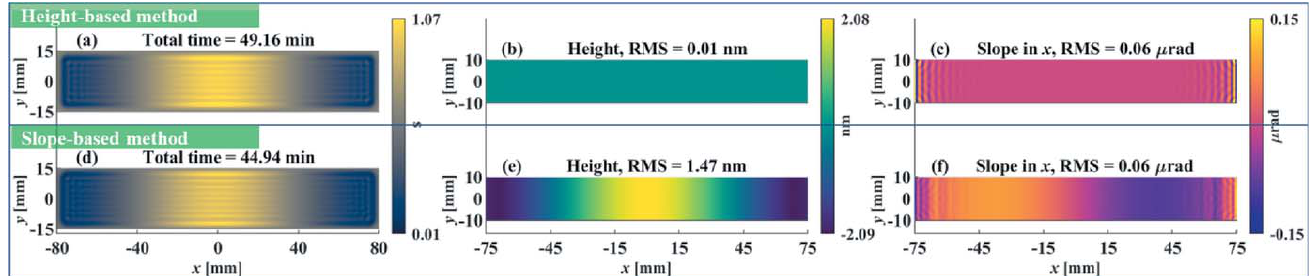
Figure 3 Dwell time, residual height errors and residual slope errors estimated from the height-based method ( a – c ) and slope-based method ( d – f ), respectively, for the sinusoidal surface shown in Figs. 1( a ) and 1( b ) with f x = 150 mm (cid:2) 1 .